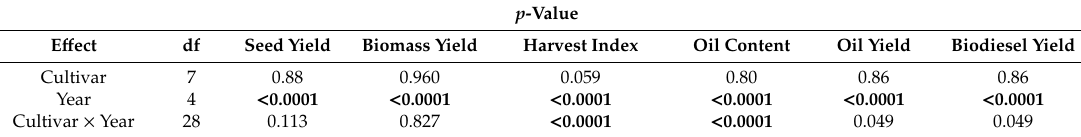
Table 2. F-statistic in the type 3 tests of fixed e ff ects for seed yield, biomass yield, harvest index, oil content, and oil yield for C. sativa as a ff ected by cultivar, year, and their interactions during the spring growing season of 2011 through 2015, at the Nevada Agricultural Experiment Station at the Valley Road Field Laboratory of University of Nevada, Reno, Reno, NV. Values are probabilities for the F-statistics. Bold fonts represent the significant e ff ect on our measured variables.